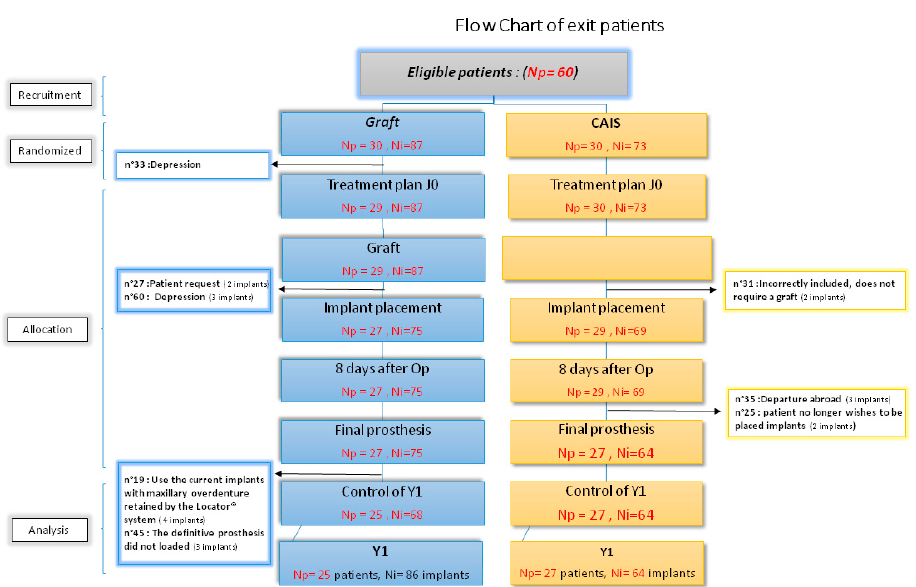
Figure 2. Flow chart of SINIMAGE. Y: year; CAIS: computer assisted implant surgery; SINIMAGE: SinusImage (the study name); Np: number of patients; Ni: number of implant; n°: patient number; Op: surgical opération.